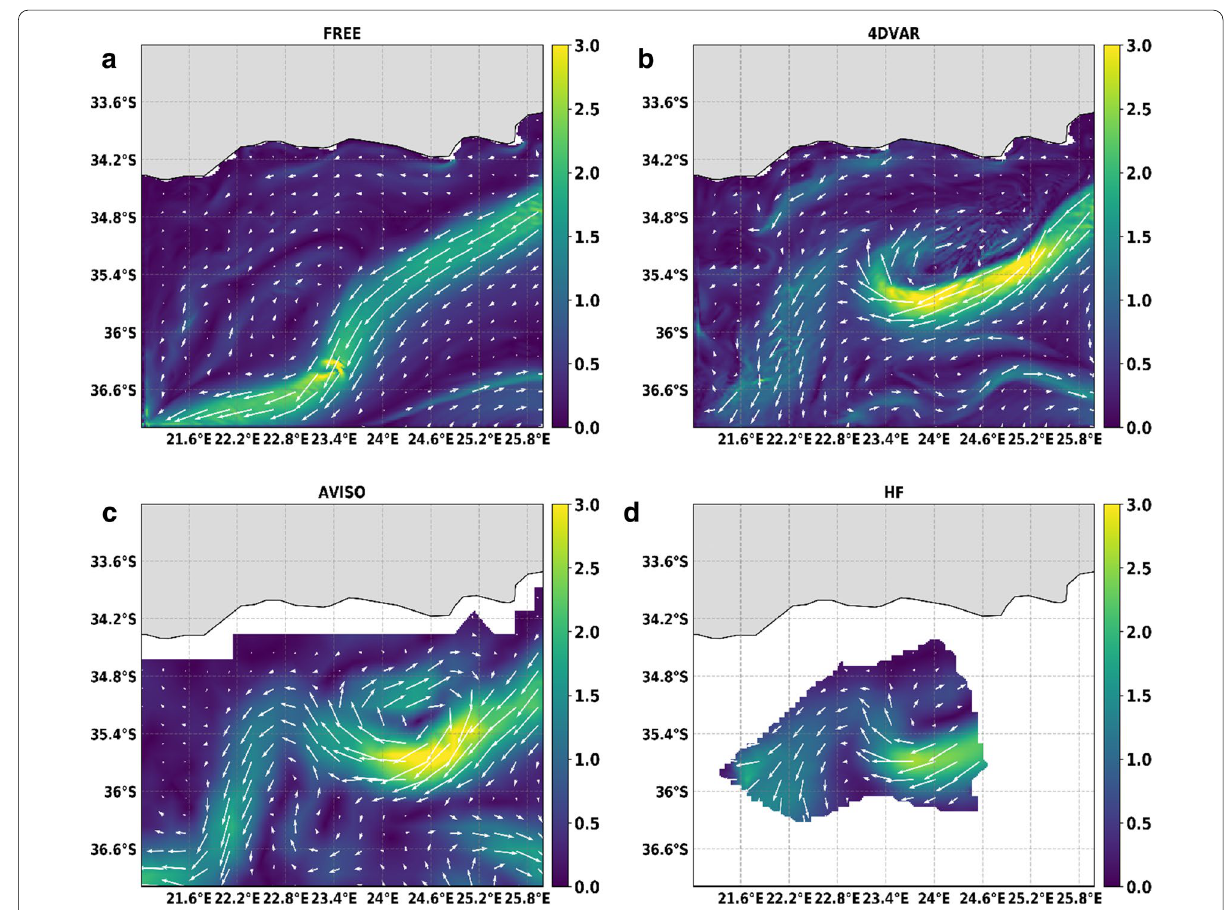
Fig. 6 Daily averaged geostrophic currents for the 23 April 2020 for: a the reference simulation, b the assimilated simulation, c from altimeters and d the assimilated HF radar data. white arrow represents current